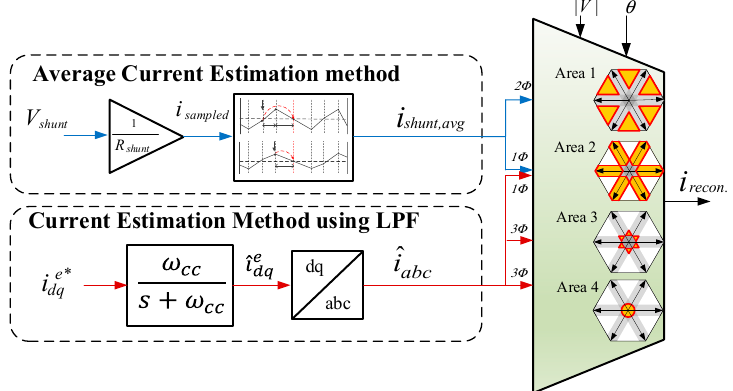
Figure 8. The proposed current estimation method by using the LPF.